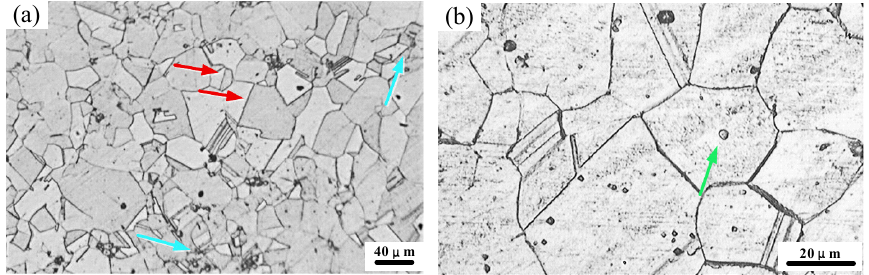
Figure 1. Metallographic structure of GH4169: ( a ) at low magnification; ( b ) at high magnification.